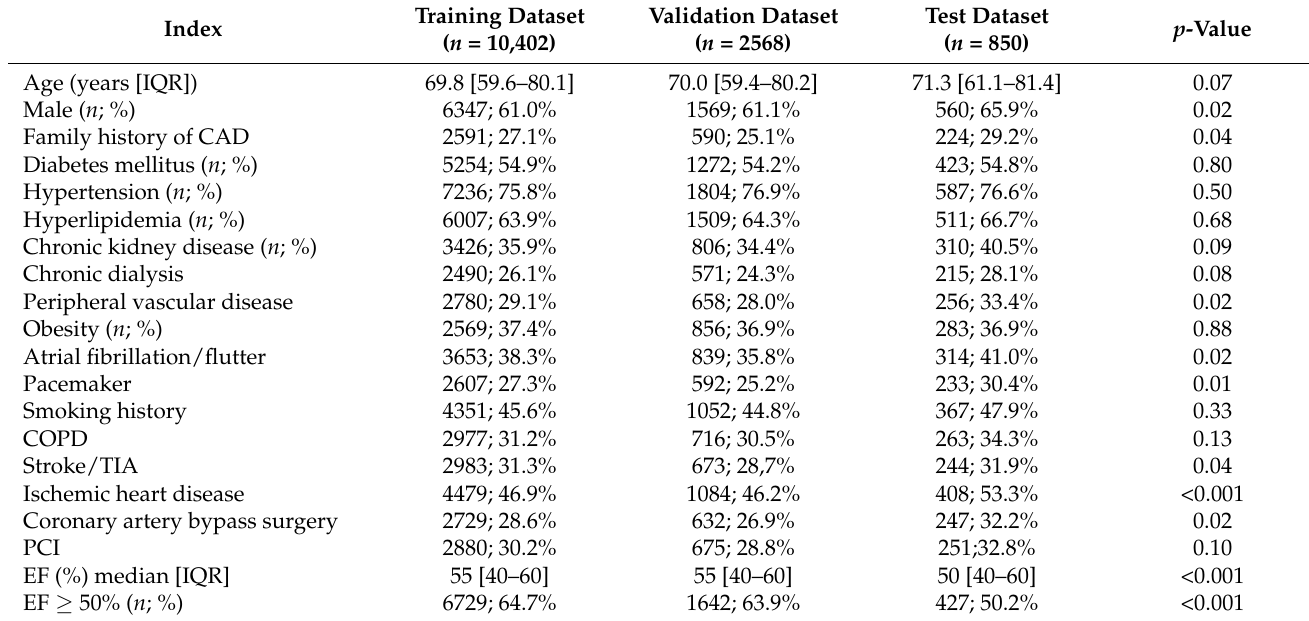
Table 1. Baseline characteristics of three datasets of echocardiography and ECG pairs.